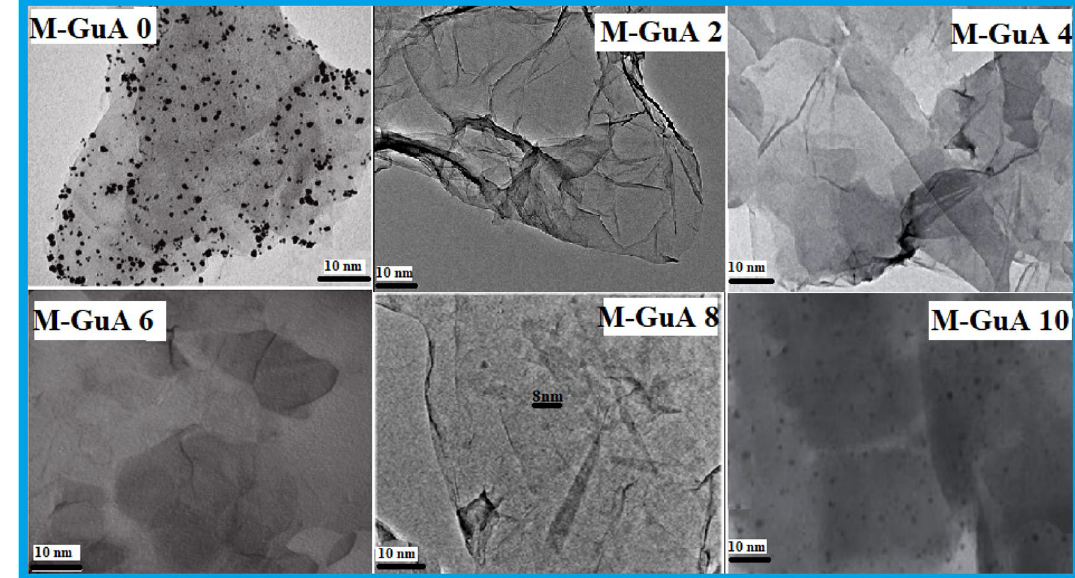
Figure 4. TEM images of M-GuA membranes.